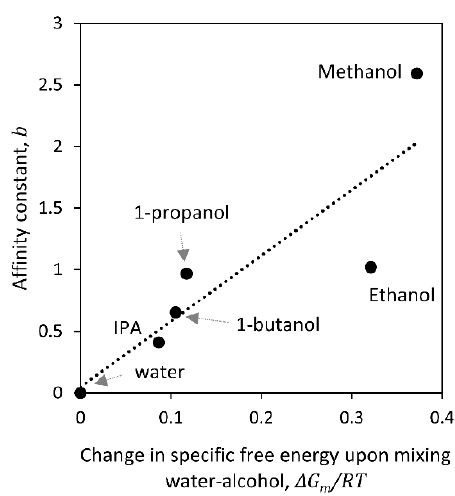
Figure 8. Affinity constant calculated from Equation (9) using the fitted K 2 for each alcohol versus the maximum change in Gibbs free energy of mixing (area under the curve in Equation (16)). The dotted line is a guide for the reader ′ s eye.